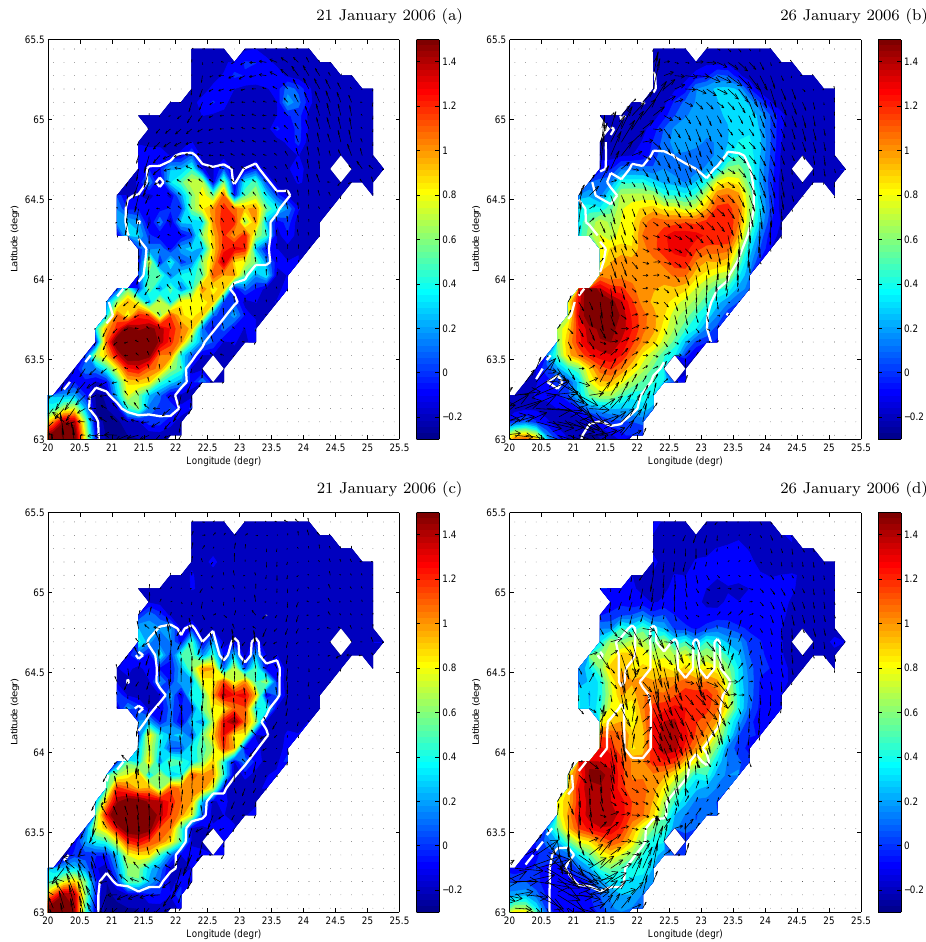
Fig. 10. Surface currents (arrows) and water temperature (shaded contours; in ◦ C) in the Bothnian Bay on 21 January 2006 (a, c) and 26 January 2006 (b, d) simulated with the sea-ice dynamics turned on (a, b) and off (c, d) . White contours correspond to ice concentration A i = 0 .